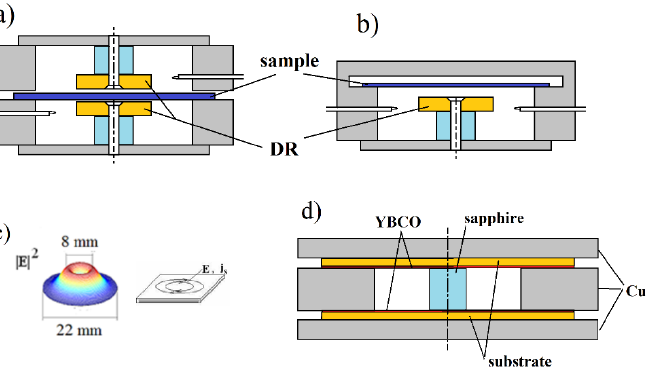
Figure 4. ( a ) Split post dielectric resonator [31,32] for measurements of low and medium loss dielectrics and high resistivity semiconductors, ( b ) single post dielectric resonator [33,34] for measurements of resistivity and the sheet resistance of semiconductors and conducting films, ( c ) electric field distribution in the single post dielectric resonator operating at 5 GHz, ( d ) sapphire rod dielectric resonator, operating on the TE 011 mode, for measurements of conductivity of metals and superconductors